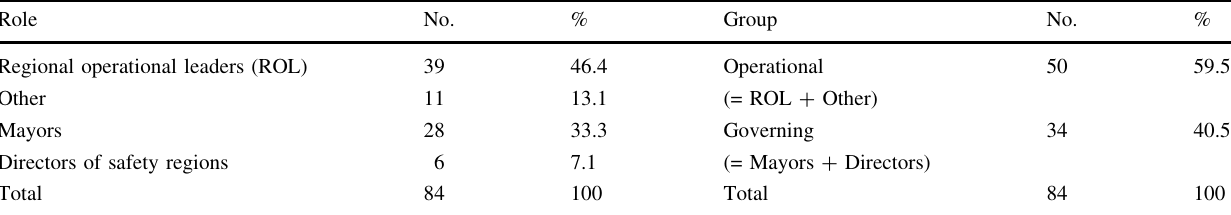
Table 3 Overview of respondents’ roles